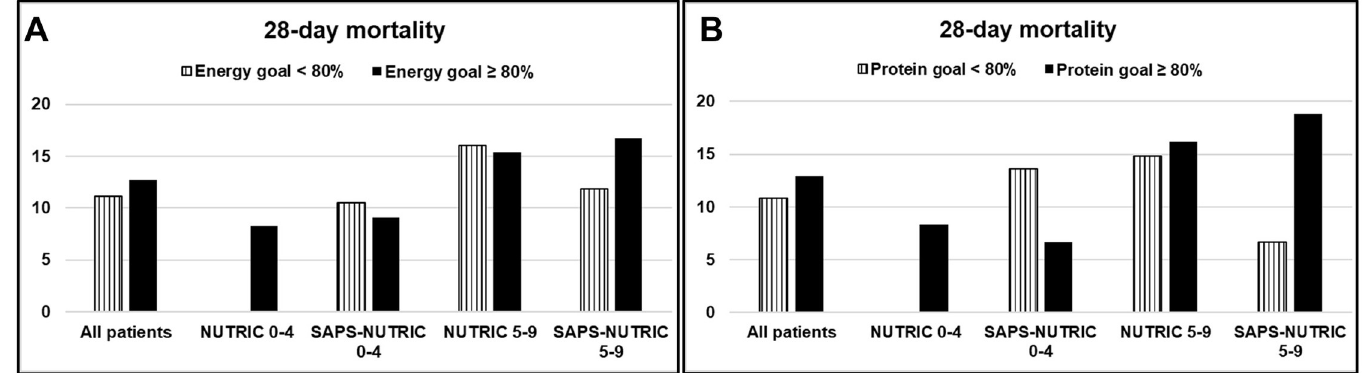
Fig 1. 28-day mortality rate stratified by nutritional risk according to the adequacy of energy (A) and protein (B) received. No differences in 28-day mortality were observed in critically ill patients who achieved or not adequate energy (A) and protein supply (B), regardless their nutritional risk (p > 0.05 for each comparison).